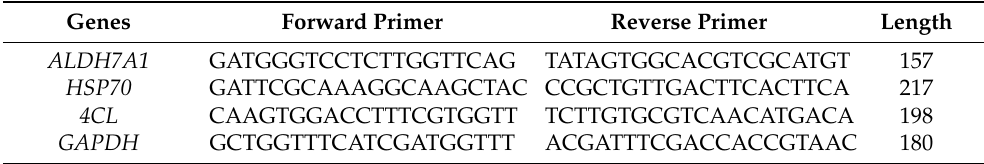
Table 1. Primer sequences for quantitative